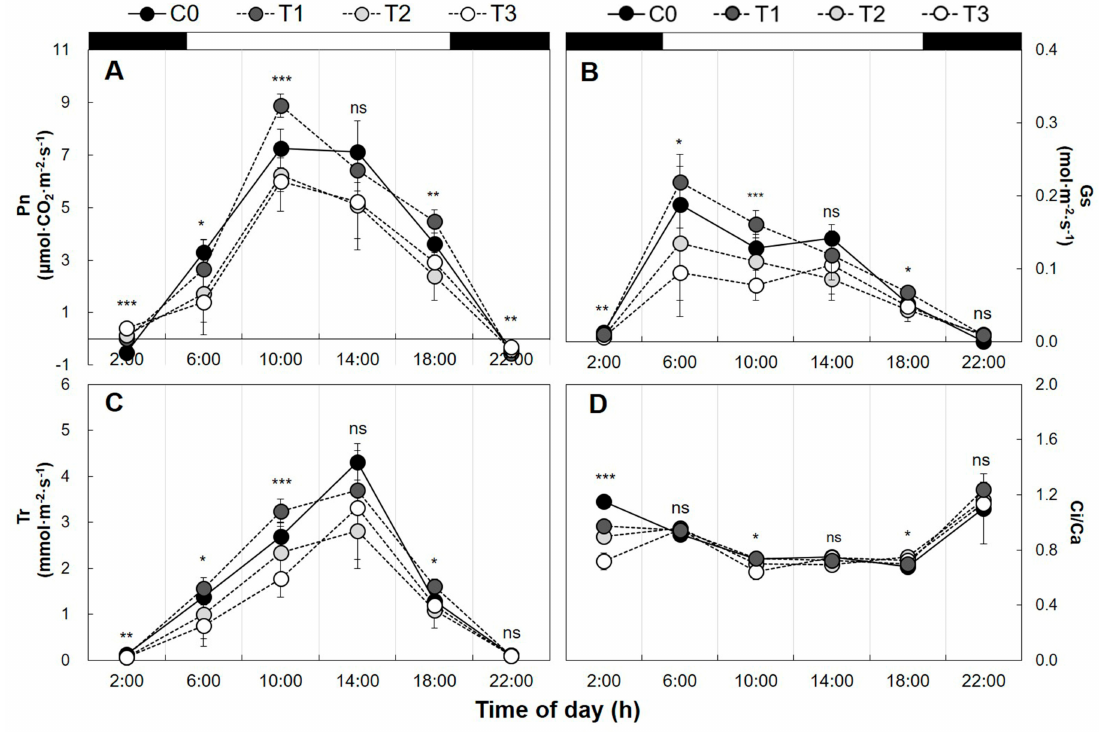
Figure 4. Diurnal patterns in leaf gas exchange parameters of yellow-poplar leaves during the 4-month treatment period. The photosynthesis during the dark period is affected by artificial night lighting. ( A ) Net photosynthetic rate (Pn), ( B ) stomatal conductance (Gs), ( C ) transpiration rate (Tr), and ( D ) ratio of intercellular (Ci) to atmospheric (Ca) CO 2 concentration (Ci/Ca ratio) of yellow-poplar plants exposed to the natural day/night cycle (C0) and the day/night with artificial lighting cycle (T1, T2, and T3). The black solid circles ( ), gray solid circles ( ), light gray solid circles ( ), and hollow circles ( ) represent C0, T1, T2, and T3, respectively. Black and white boxes at the top indicate the dark and (cid:35) light phase, respectively, in the daily cycle. The x -axis represents the time of day (h). Data points represent mean ± SD ( n = 5). Asterisks represent a significant difference among treatments (* p < 0.05; ** p < 0.01; *** p < 0.001; ns, not